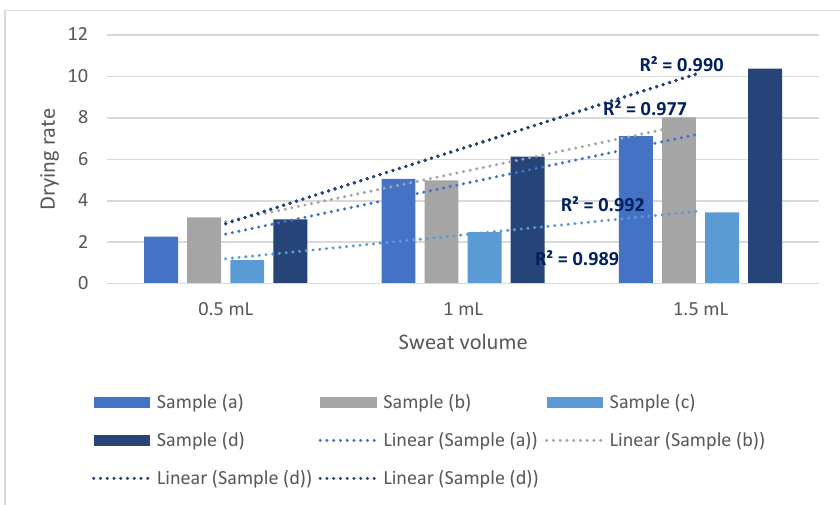
Figure 6. Sweat drying performance of protective fabrics at 1.5 m/s ambient air speed.